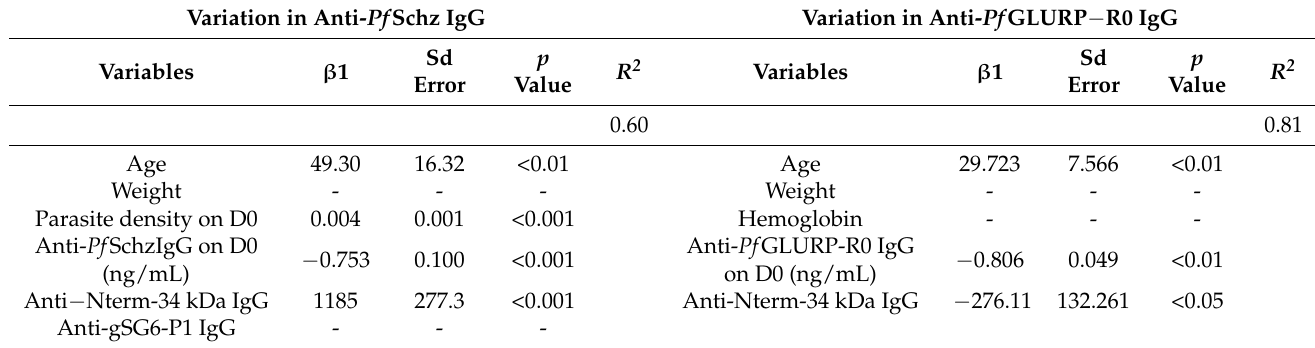
Table 3. Results of multivariate analysis indicating factors associated with variation in IgG responses to P. falciparum antigens during the